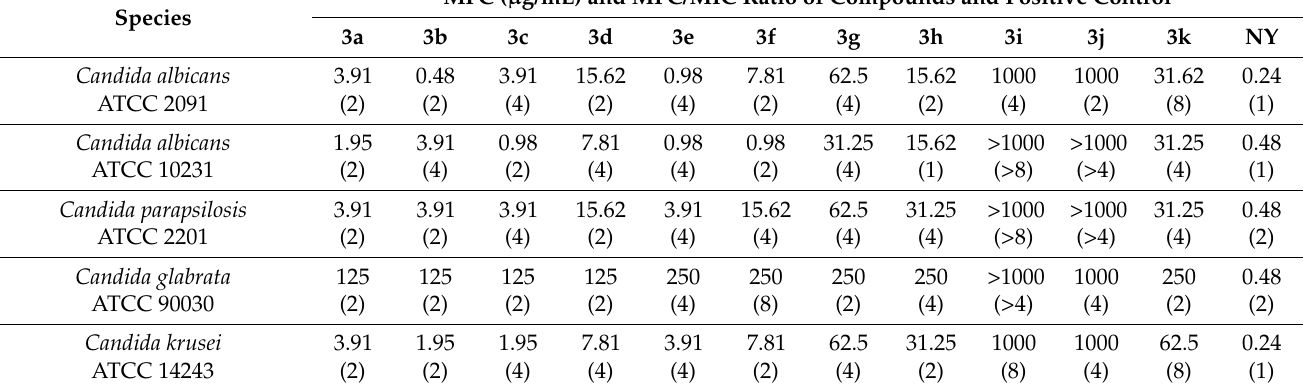
Table 4. The activity data of compounds expressed as MFC ( µ g/mL) and MFC/MIC ratio against the reference strains of fungi. The standard antibiotic—nystatin (NY) was used as positive control.